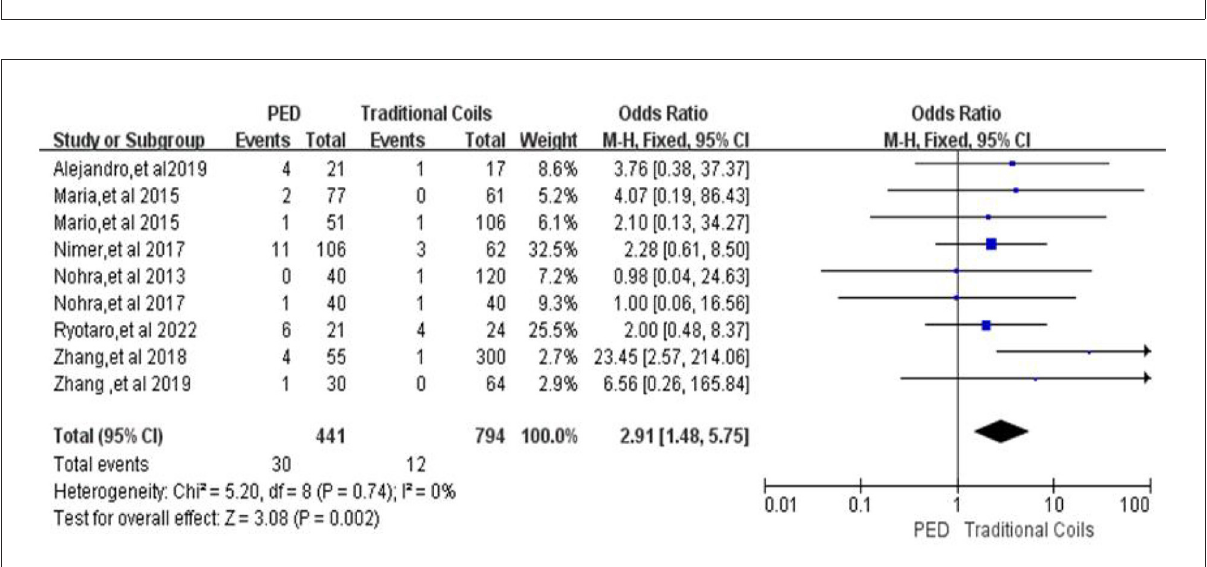
FIGURE3 Forest plot and meta-analysis of procedure-related intracranial ischemia.